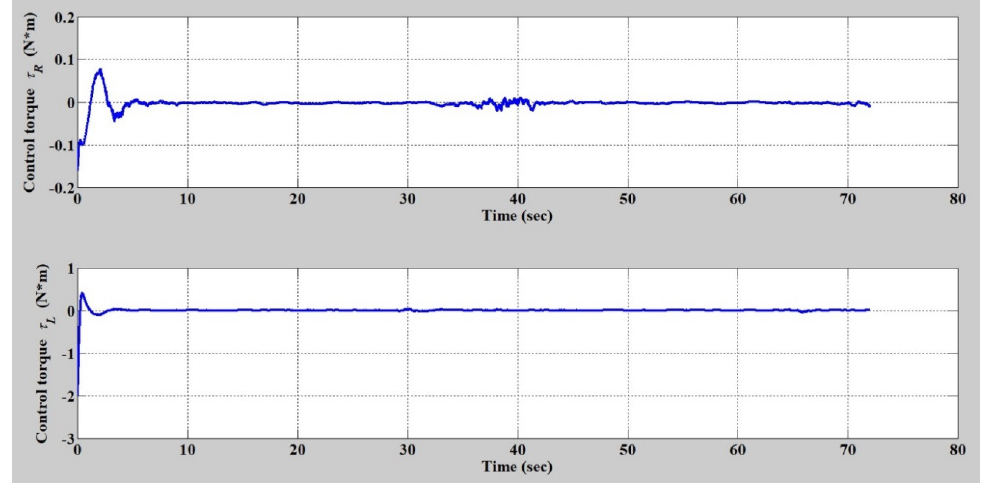
c = 0 m, y c = − 1.9 m).